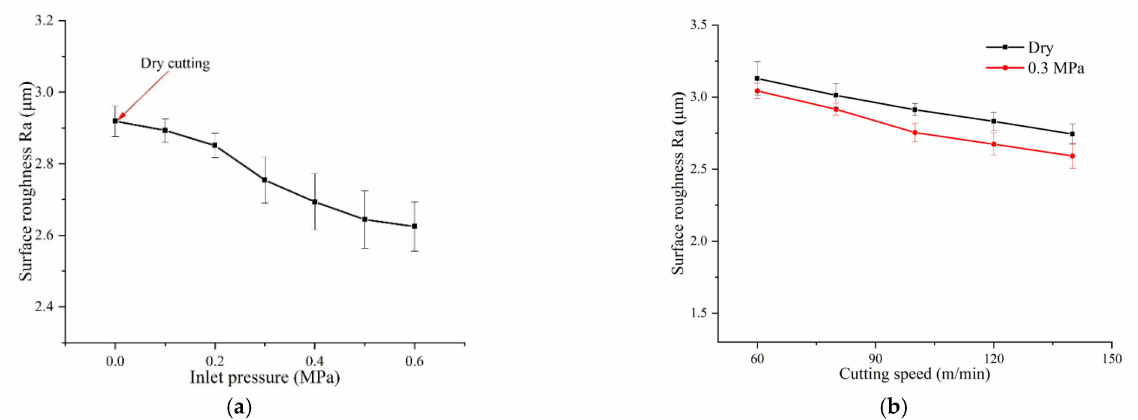
Figure 13. Effect of cooling conditions on machined surface roughness of workpiece. ( a ) Surface roughness of workpiece under different spray pressure at a cutting speed of 100 m/min, ( b ) The spray cooling and dry cutting roughness at different cutting